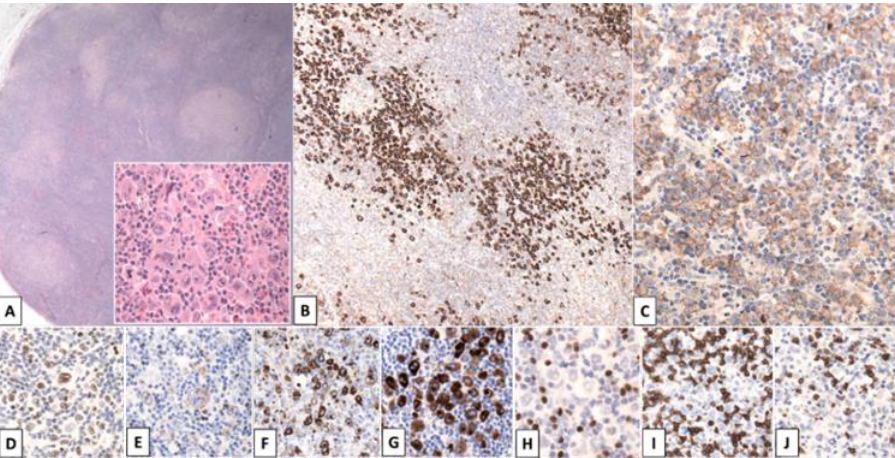
Figure 6. Lymphocyte rich CHL with expression of cytotoxic markers versus ALCL ALK- with CHL-like morphology. Enlarged inguinal lymph node of 3 cm in a 62-year-old male patient. Nodular growth pattern with HRS cells (( A ); A inset). HRS cells are interspersed in nodules comprising CD20 positive small B lymphocytes ( B ), whereas the large cells show a clear CD20 negativity (B inset) as well as for other B-cell markers such as PAX5 ( C ) and CD79a ( D ). Positivity for CD30 ( E ), CD15 ( F ), and MUM1 ( G ) confirms the classic HL phenotype with an aberrant expression of cytotoxic markers as shown by perforin positivity ( H ). PD1 positive Tfh lymphocytes rosetting around HRS cells ( I ). [Original magnification: A: 100×; A inset: 400×; B: 50×; B inset: 200×; C, D, H, I: ×400; E – G: ×200].